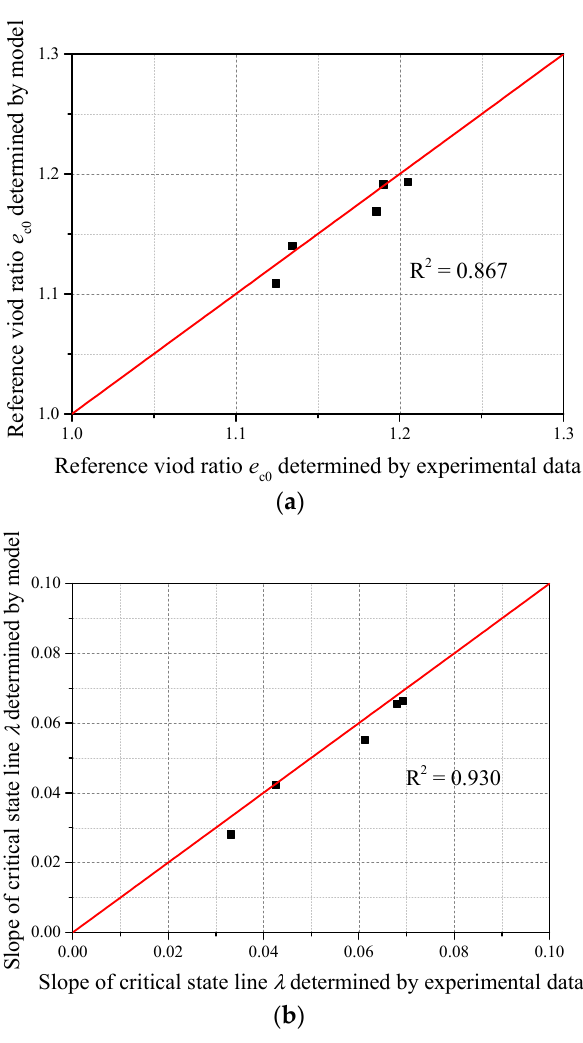
Figure 11. Comparison of material constants determined by the model with experimental data: ( a ) reference void ratio e c 0 ; ( b ) slope of critical state lines λ .